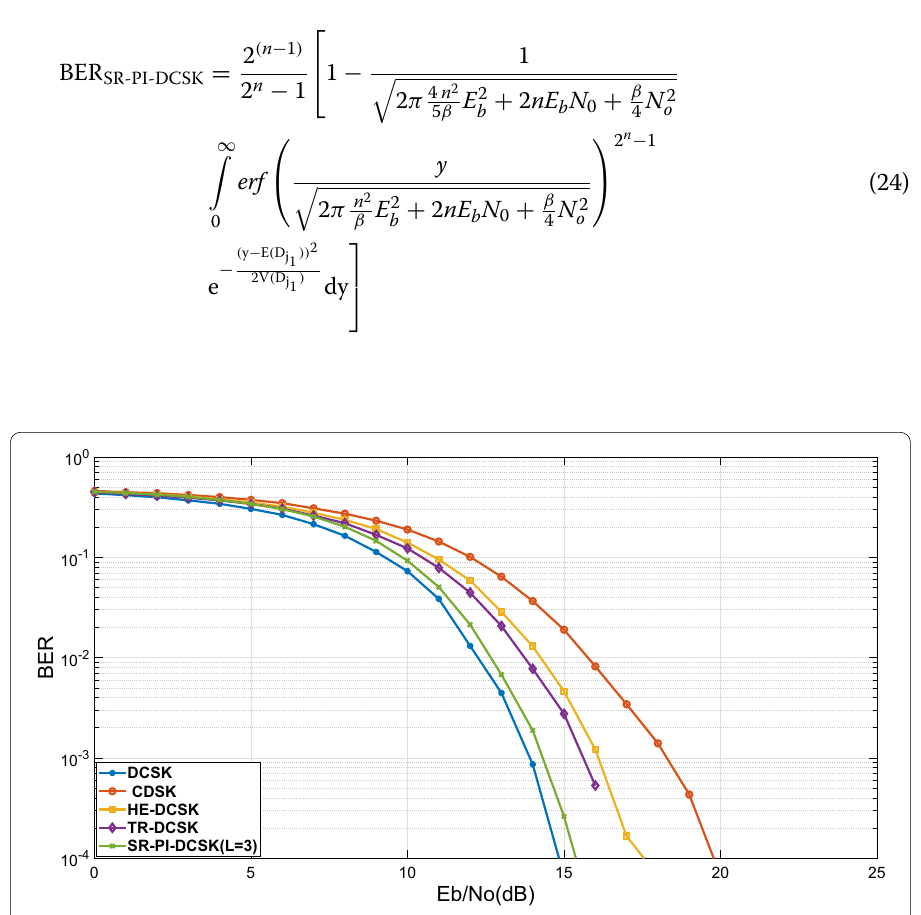
Fig. 4 The bit error rate performance of SR‑PI‑DCSK versus DCSK, CDSK, HE‑DCSK, and TR‑DCSK for β = 100